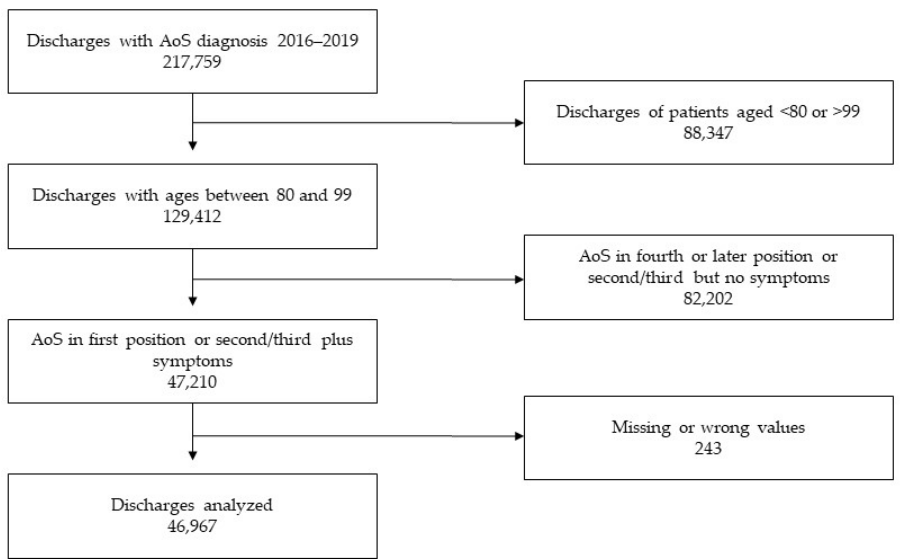
Figure 1. Flowchart of the discharges included.